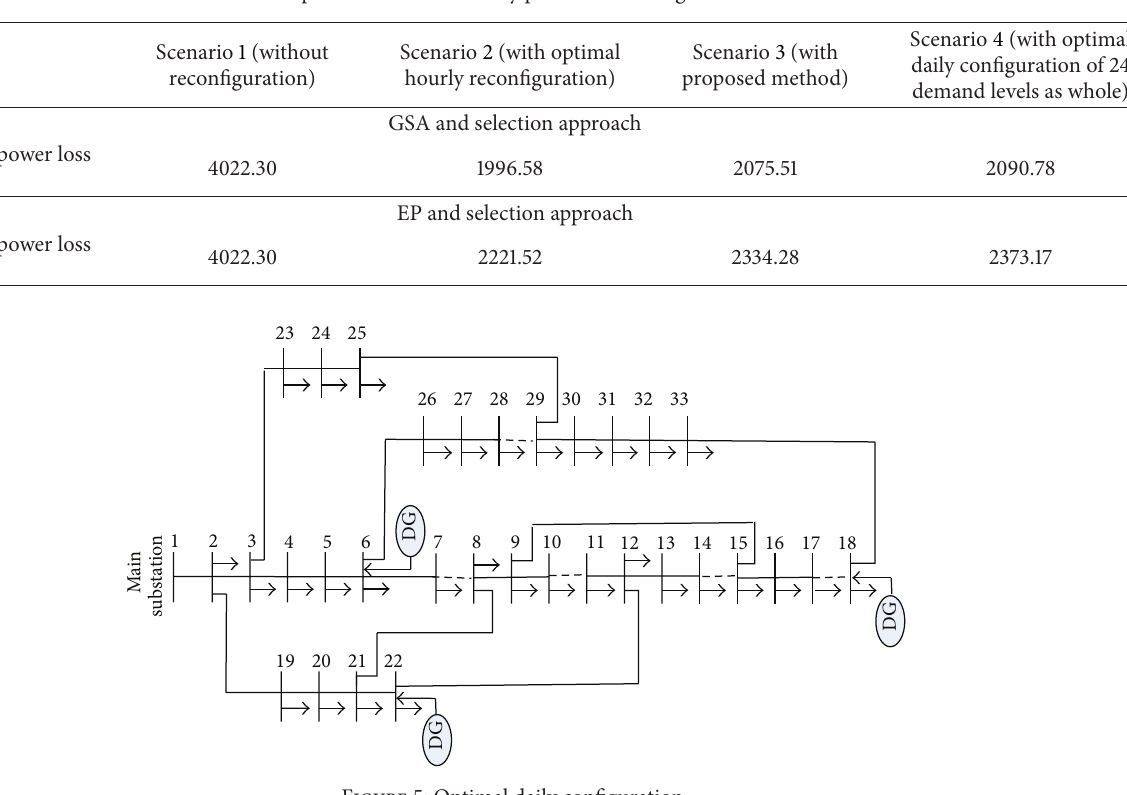
Table 2: Comparison of the total daily power loss among the four scenarios.